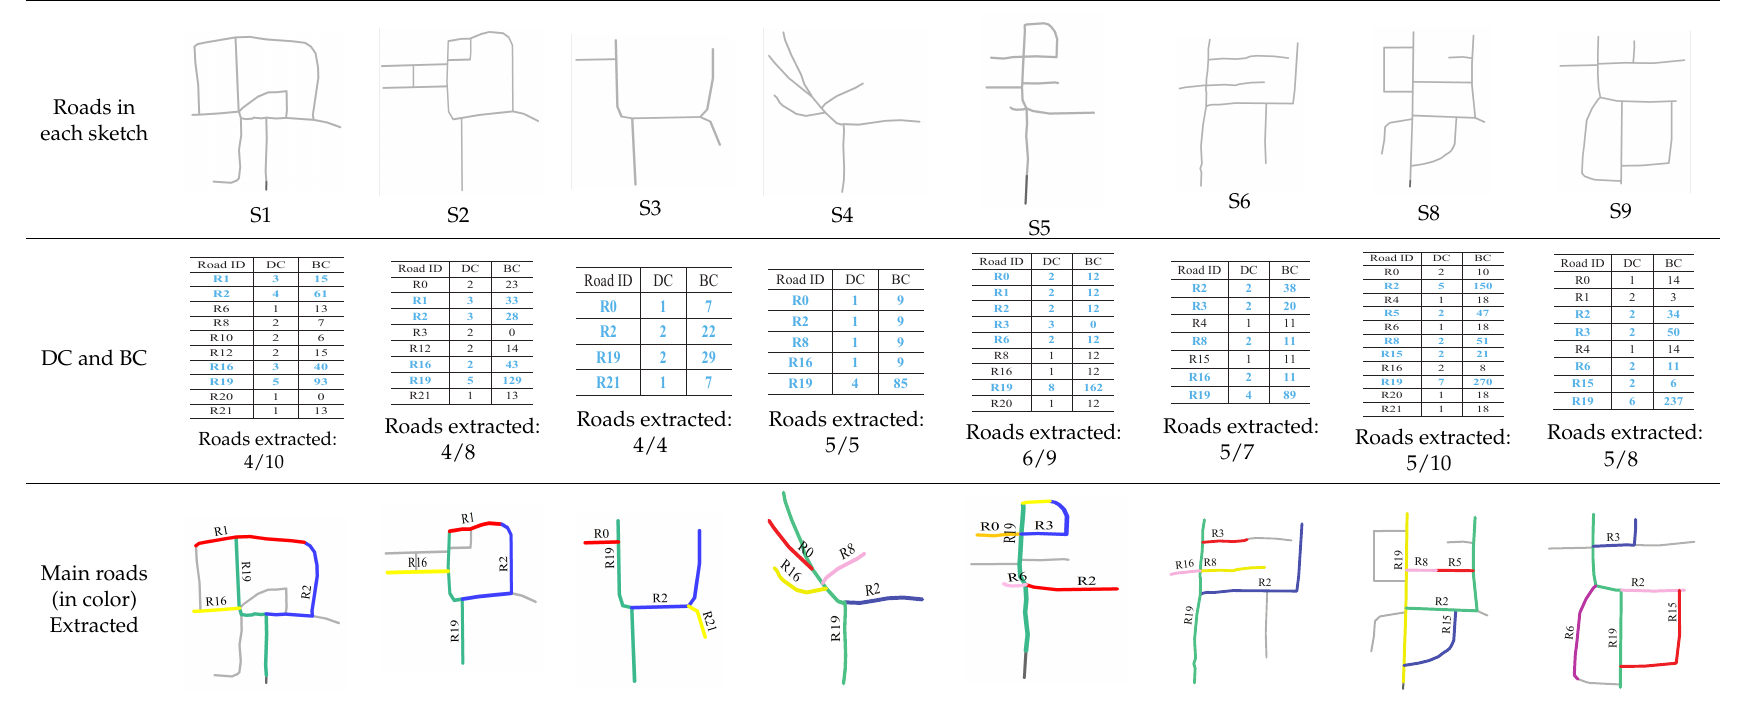
Table 4. Main roads extracted from each sketch w.r.t. DC and BC . Note that roads in sketch S7 were all extracted as main roads, because there are only two roads in the